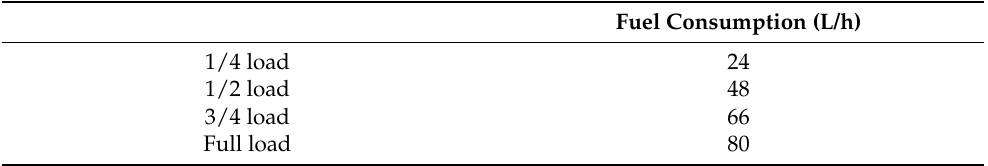
Table 3. DG units fuel consumption chart.